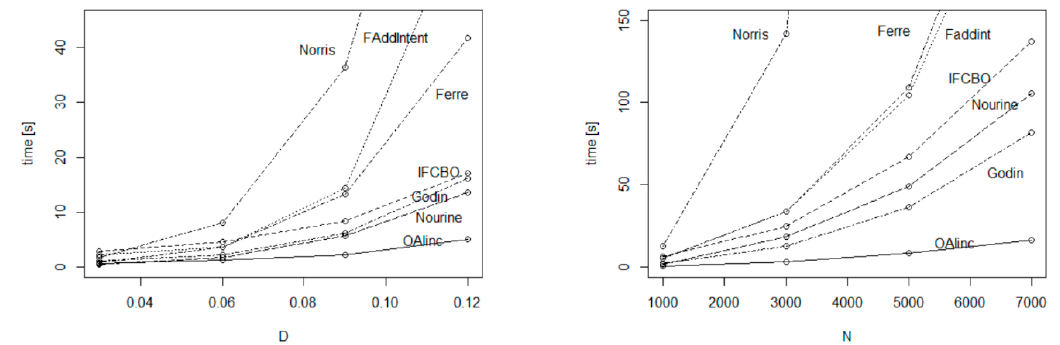
Figure 1. Execution cost function (N = 1000, M = 100) for left side; (M = 150, density level = 7) for right side.